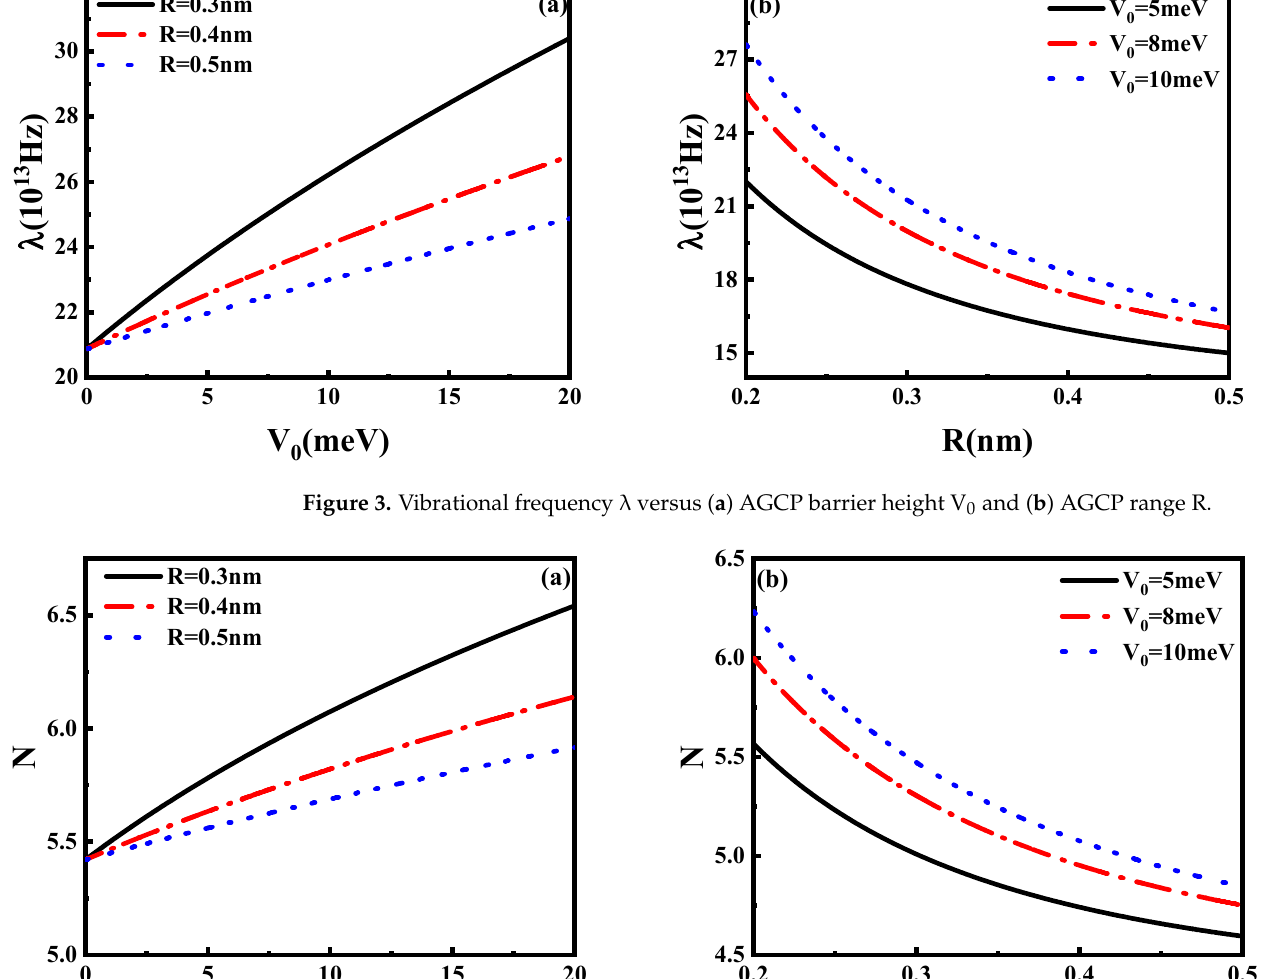
versus ( a ) AGCP barrier height V (cid:2912)